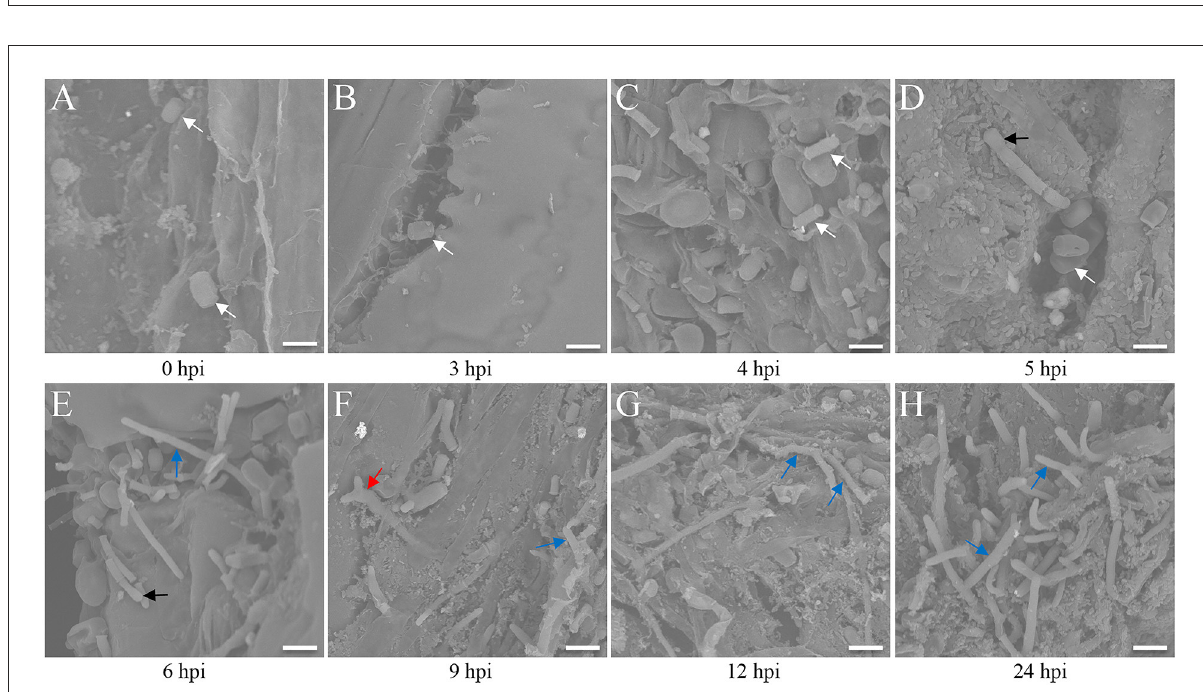
FIGURE2 Scanning electron microscopy analysis of maize leaves after Ustilago maydis inoculation. (A–H) Three-week-old Ye478 seedlings cultivated in an artificial climate chamber were inoculated, and the hyphal developmental behavior on the interface was captured at 0, 3, 4, 5, 6, 9, 12, and 24 hpi, respectively. White arrow: strain; black arrow: appressorium; blue arrow: hypha; red arrow: branch. Scale bar = 100 µ m.